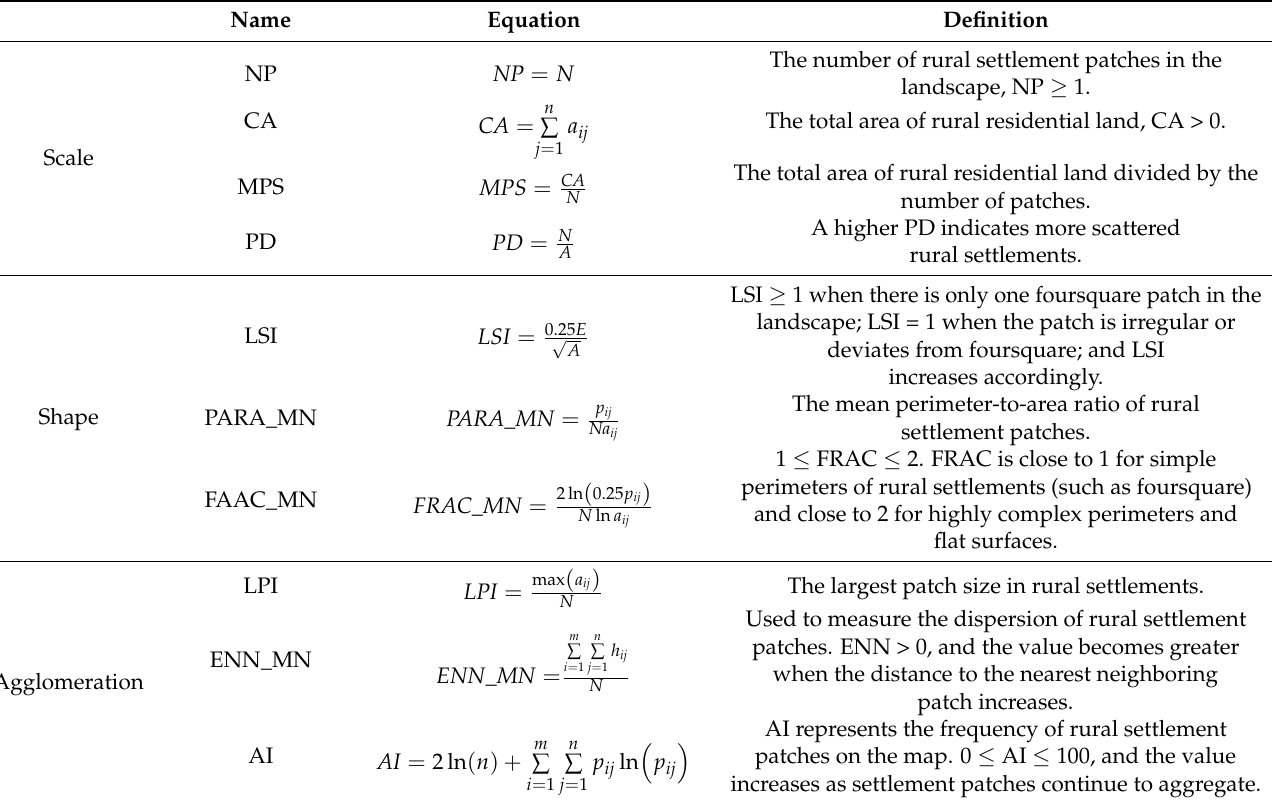
Table 2. The equations and definitions of landscape